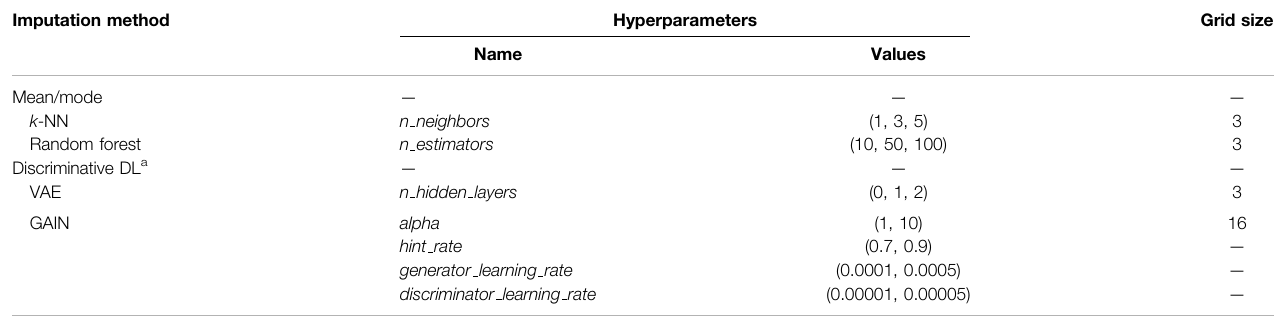
TABLE 5 | An overview ofall imputation methods and their hyperparameters we optimized. Mean/mode imputation does not have any hyperparameters, and Discriminative DL is optimized using autokeras, which is why we do not explicitly de fi ne a hyperparameter grid.